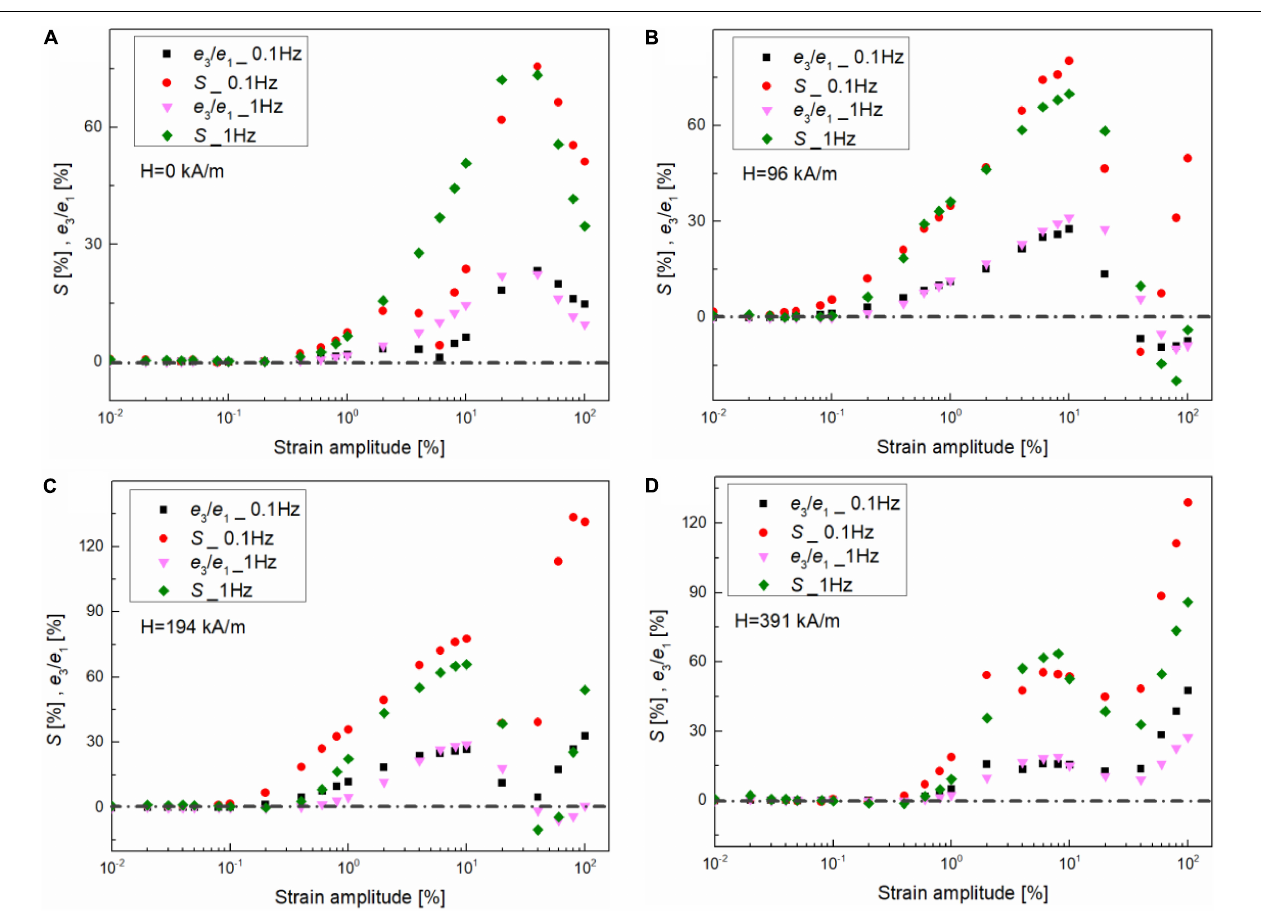
FIGURE 9 | Strain dependence of third-order elastic Chebyshev coefficient, i.e., e 3 / e 1 , and strain-stiffening ratio, S , for MRG-70 under different oscillatory frequencies, i.e., 0.1 and 1 Hz. The LAOS test was conducted on four different magnetic fields, such as (A) 0, (B) 96, (C) 194, and (D) 391 kA/m. The dashed lines indicate the value of